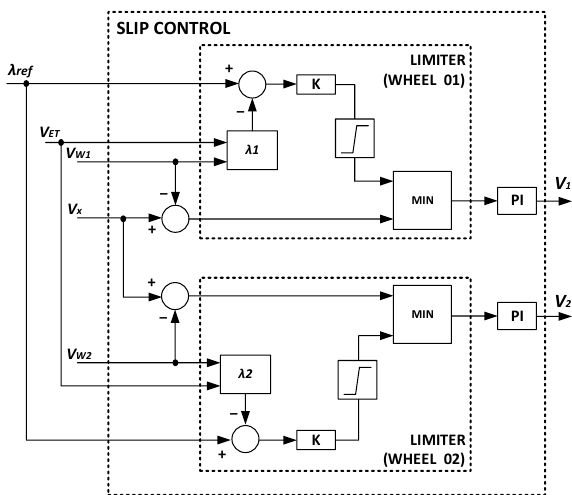
Figure 3. Proposed slip control system.